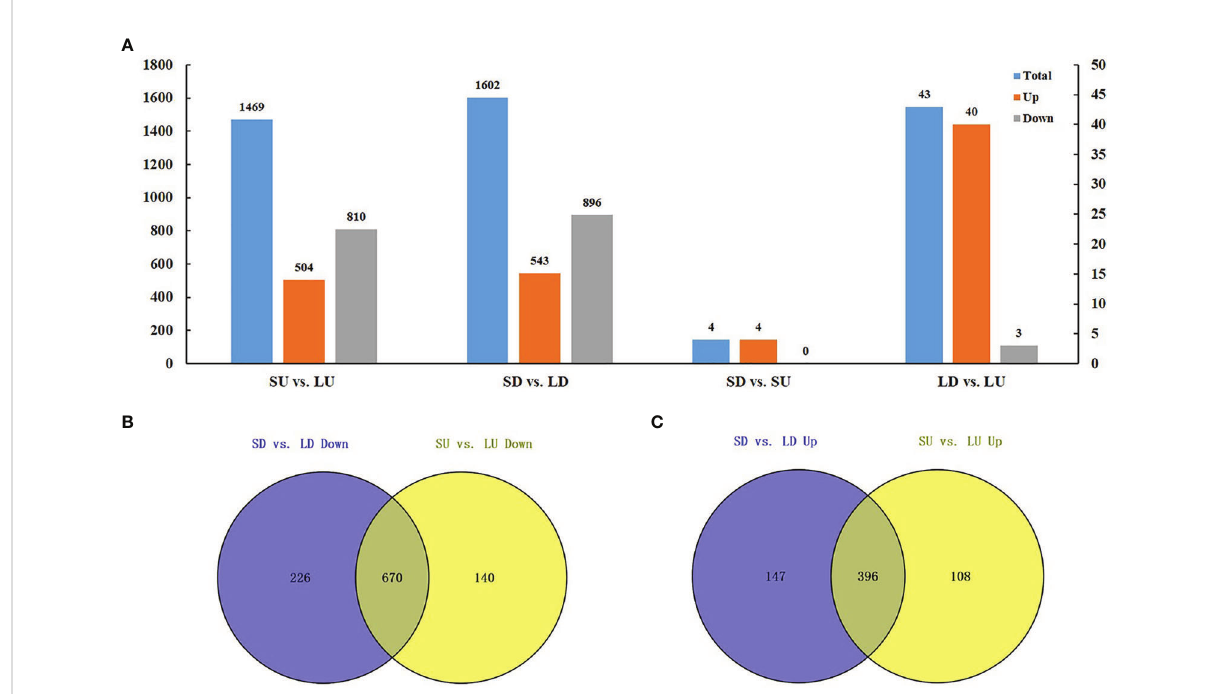
FIGURE 6 Transcriptomic analysis of branch angle in oilseed rape. (A) Statistical analysis of DEGs. SU vs. LU means the comparison between small- and large- branch angle accessions on the adaxial side. SD vs. LD means the comparison between small- and large- branch angle accessions on the abaxial side. SD vs. SU means the comparison between the branches adaxial and abaxial side of the small-angle accessions. LD vs. LU means the comparison between the branch ’ s adaxial and abaxial side of the large-angle accessions. The blue rectangle indicates all DEGs in the combination. The orange indicates consistently upregulated DEGs. The gray indicates consistently downregulated DEGs. (B) Upregulated DEGs between small- and large- branch angle accessions. (C) Downregulated DEGs between small- and large- branch angle